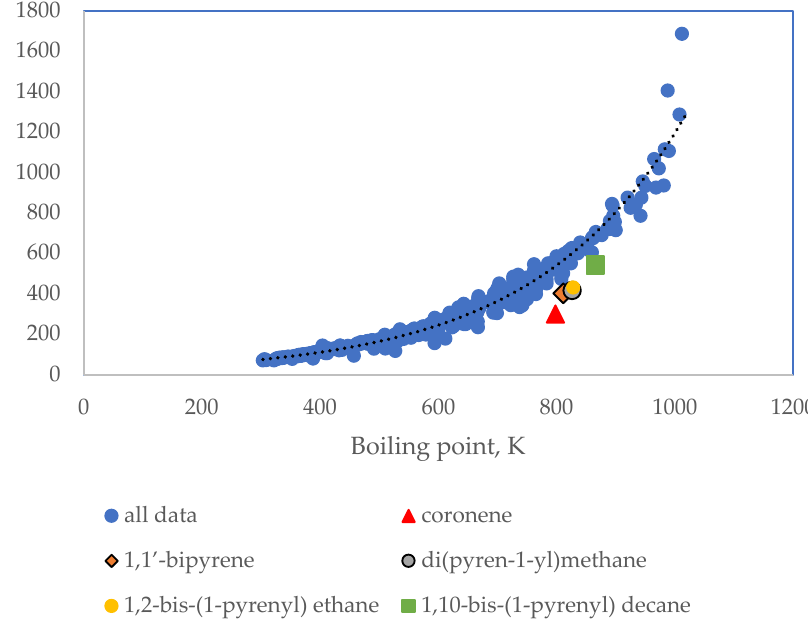
Figure 1. Dependence of molecular weight on boiling point for petroleum fluids and individual hydrocarbons.